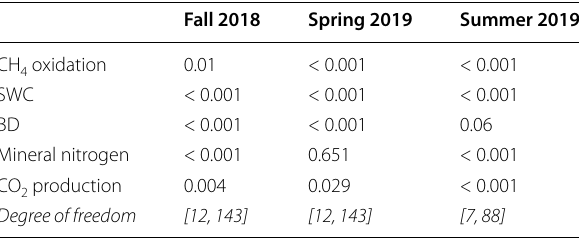
Measurements were done on 13 stands in fall 2018 and spring 2019 (stand ID 4–16) and on 8 stands in summer 2019 (stand ID 1–8), with 12 replicates per stands. Degrees of freedom of the factor (stand ID) and of the residuals are given in the last row